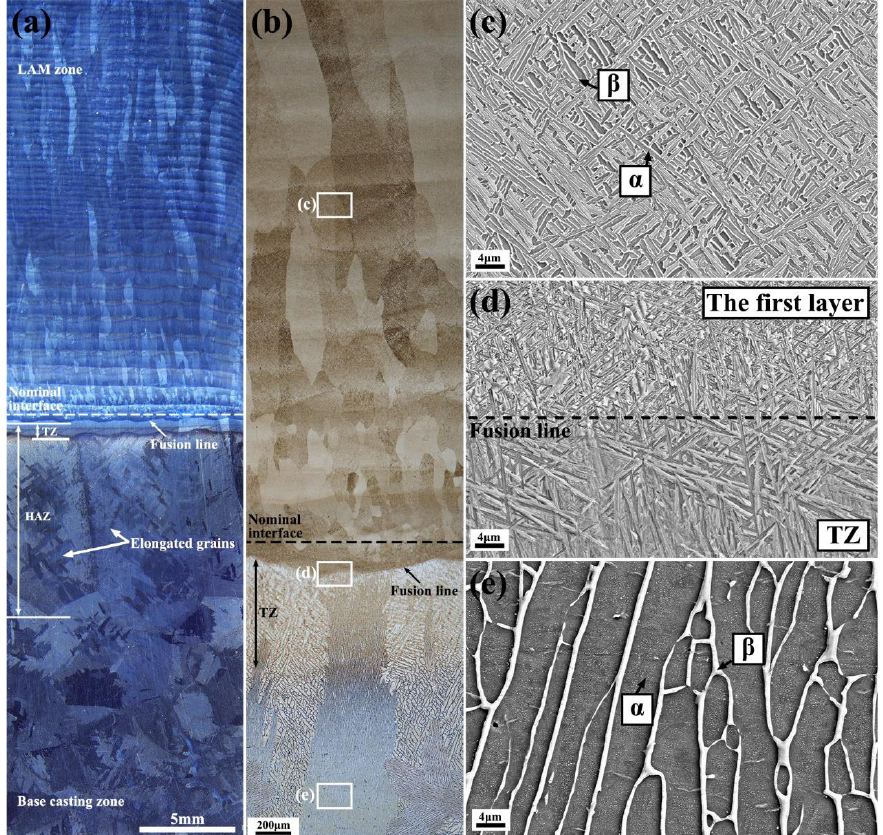
Figure 2. ( a ) Macrostructure of the hybrid sample in YZ plane, ( b ) OM image of the hybrid sample showing different regions, ( c – e ) corresponding higher magnification images in ( b